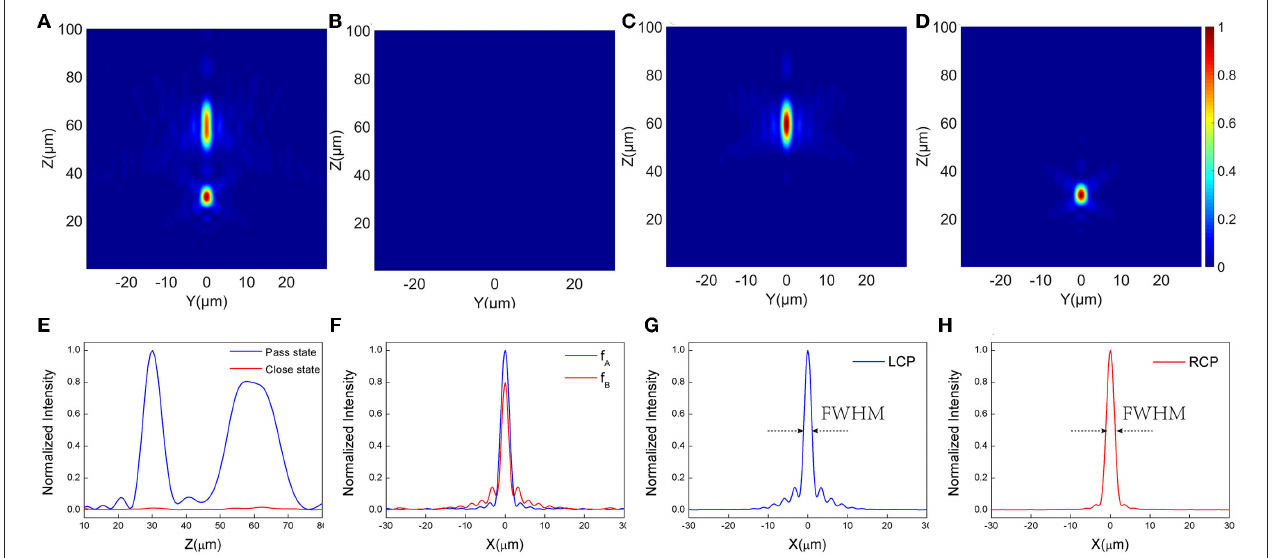
Figure 4D that the transmittance of I-VO 2 always remains at about 0.88, whether the incident light is left-handed circularly polarized light or right-handed circularly polarized light, while the transmittance of M-VO 2 varies between 0 and 0.2, It is in line with the situation that the transmittance of I-VO 2 is much greater than that of M-VO 2